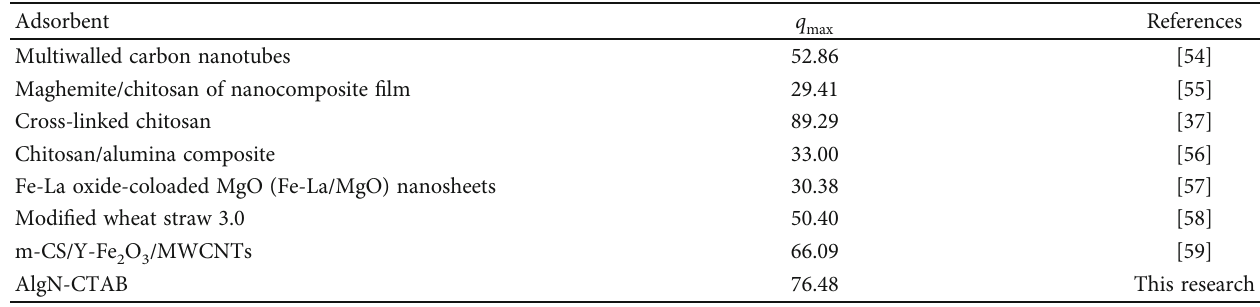
Table 4: Comparing the adsorption capacity of MO on AlgN-CTAB with other adsorbents.